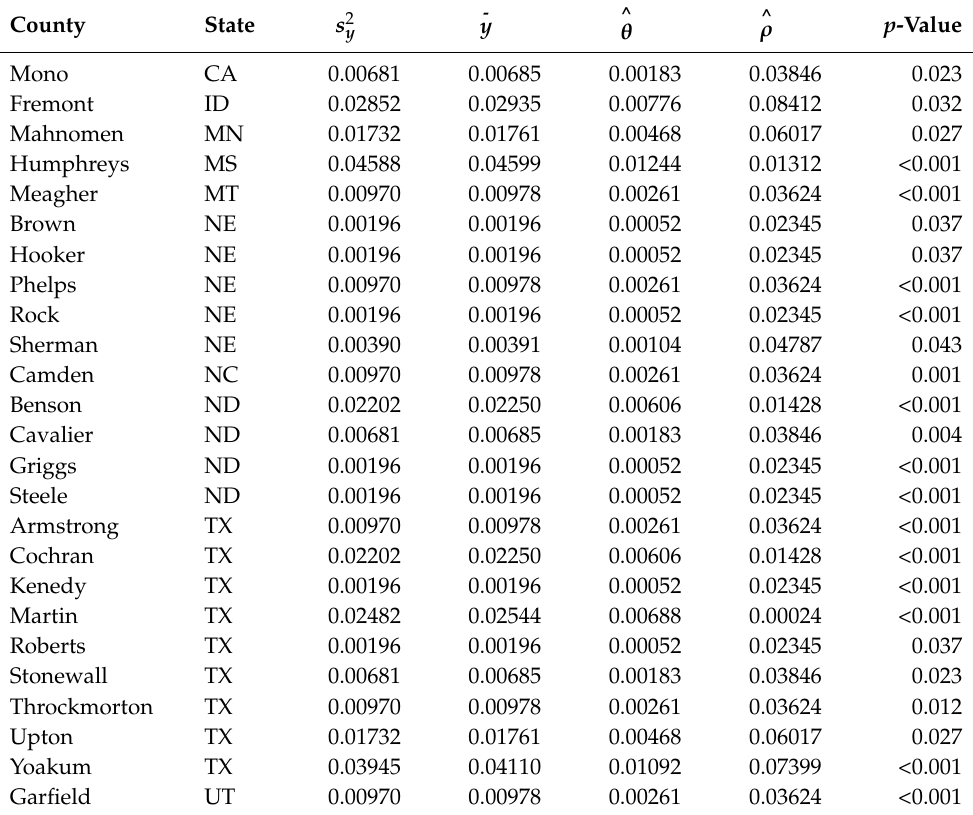
Table 3. Summary of county, state, n, dispersion, mean, estimate of efficacy of efforts, p -value for COVID